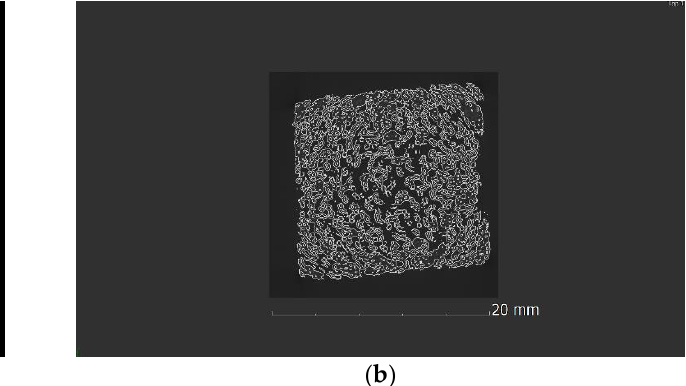
Figure 10. SEM image of ( a ) a fractured strut wall of reticulated porous coated with zirconia once, ( b ) thick reticulated porous coated with zirconia twice, and ( c ) a filled strut wall of reticulated porous coated with zirconia three times.